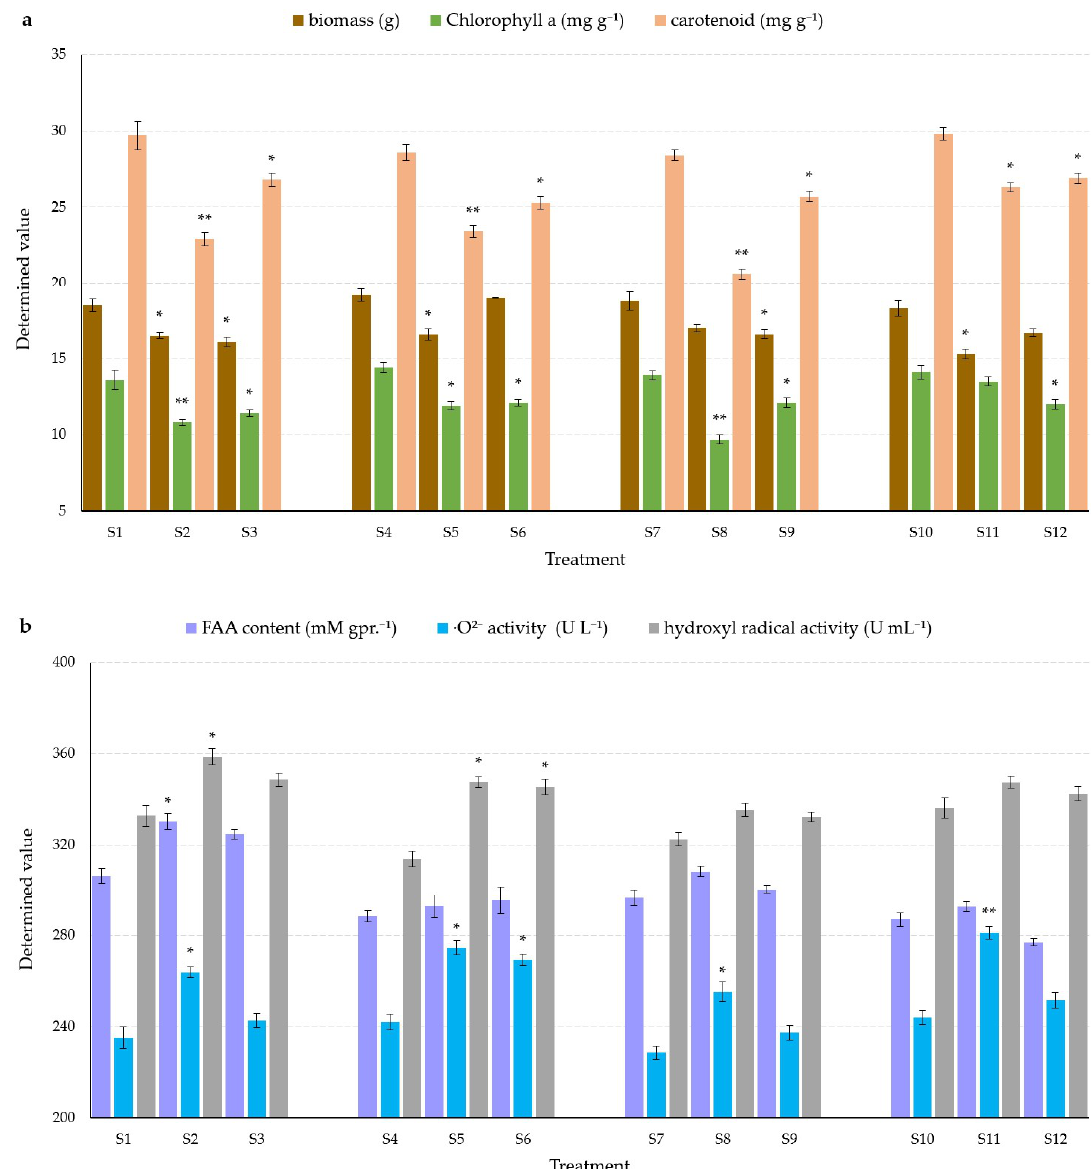
Figure 1. E ff ects of the target PAEs on physiological changes in ( a ) biomass (g), chlorophyll a content (mg g − 1 ), and carotenoid content (mg g − 1 ); and ( b ) free amino acid (FAA) content (mM per gram protein − 1 (mM gpr. − 1 )), superoxide anion free radical activity (U L − 1 ), and hydroxyl radical activity (U mL − 1 ) of water spinach under di ff erent soil conditions. S1, S2, and S3 correspond to 0 control, DBP 20, and DEHP 20 mg kg − 1 , respectively, all at pH 7.0, 2.0% SOM, 80% maximum WHC; S4, S5, and S6 correspond to 0 control, DBP 20, and DEHP 20 mg kg − 1 , respectively, all at pH 8.5, 2.0% SOM, 80% maximum WHC; S7, S8, and S9 correspond to 0 control, DBP 20, and DEHP 20 mg kg − 1 , respectively, all at pH 7.0, 4.0% SOM, 60% maximum WHC; and S10, S11, and S12 correspond to 0 control, DBP 20, and DEHP 20 mg kg − 1 , respectively, all at pH 8.5, 4.0% SOM, 60% maximum WHC. Each value is the mean of four replicates ± SEM. * significantly di ff erent at p < 0.05; ** significantly di ff erent at p < 0.01 according to a Duncan’s multiple range test within each group compared with the corresponding controls